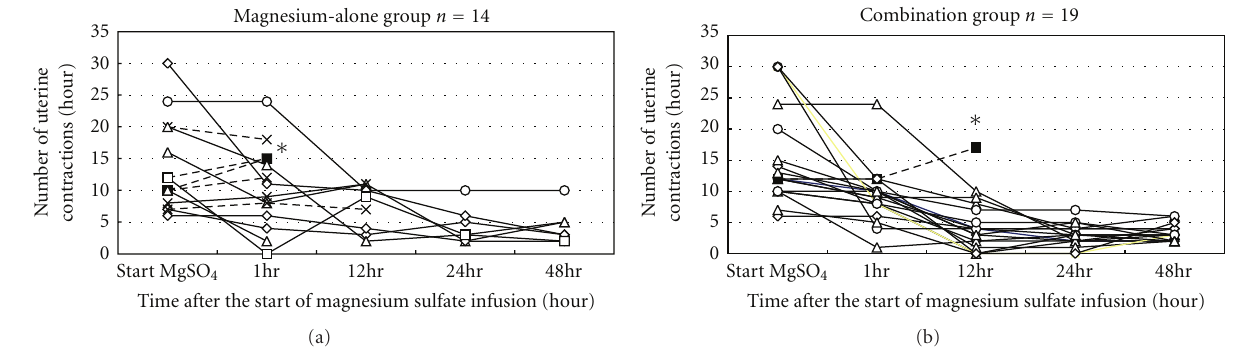
Figure 2: Temporal changes in uterine contractions after the start of magnesium sulfate treatment in the magnesium-alone group (a) and combination group (b). The dotted lines in the magnesium-alone group represent those who required reinfusion of ritodrine to inhibit uterine contraction. Asterisks represent those who delivered within 48 hours of magnesium infusion.